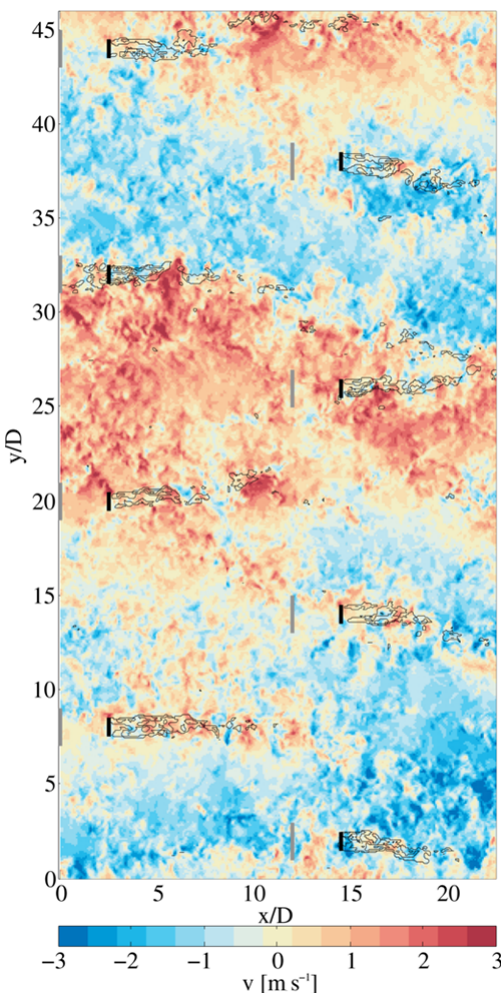
Figure 14. Example of the instantaneous v component at hub height in the CBL. Turbine wakes are denoted by black contours. Black lines denote the rotor positions, gray lines denote the posi- tion of the inflow measurement for each